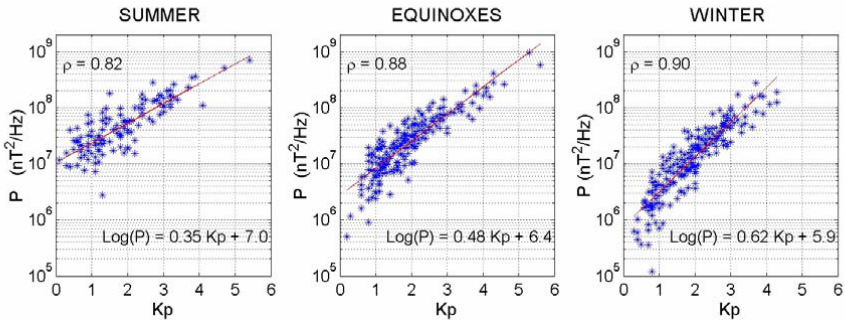
Fig. 3. The total (H+D) 24-h power versus the K p index. The equation of the best linear fit and the value of the correlation coefficient are